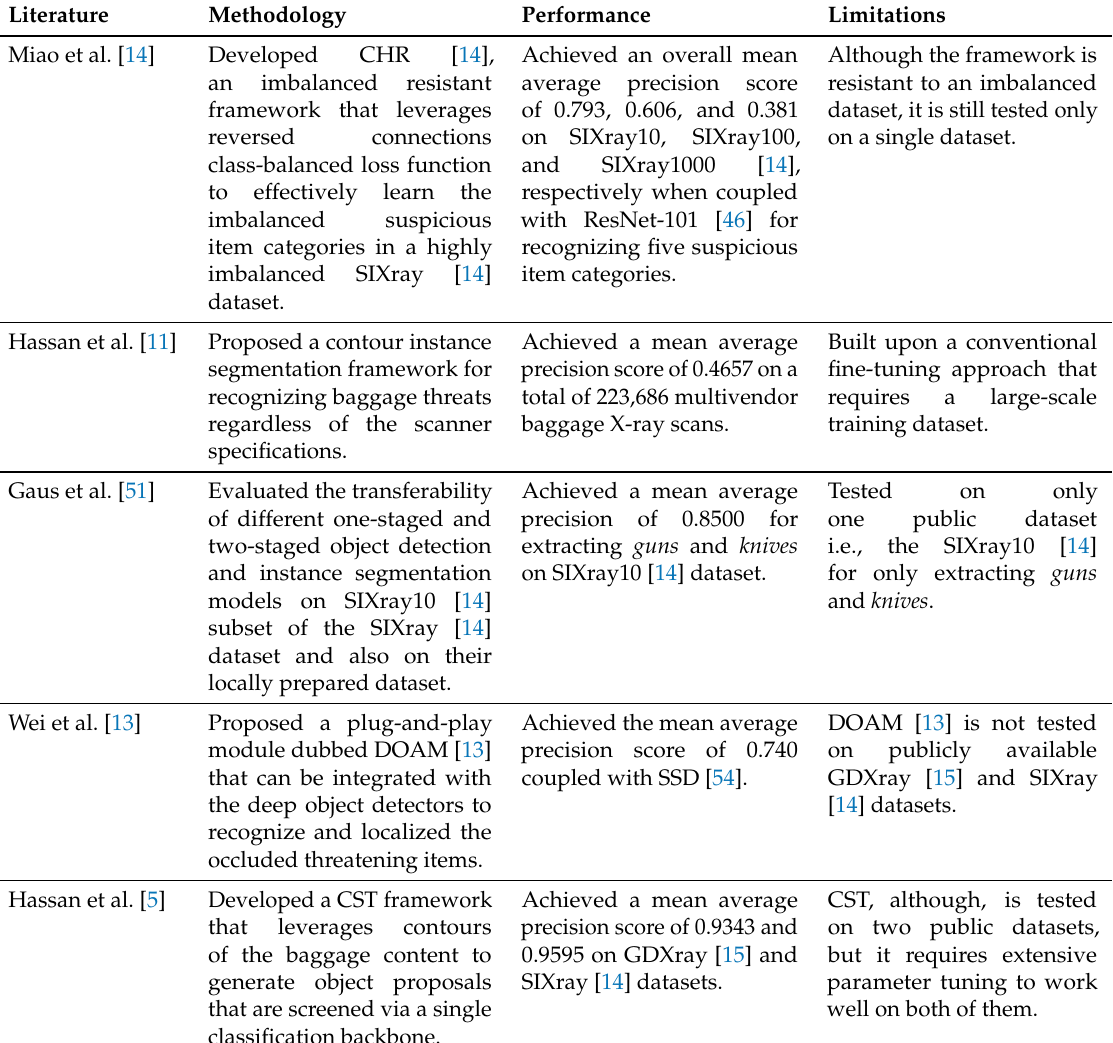
Table 1. Summary of the state-of-the-art baggage threat detection frameworks